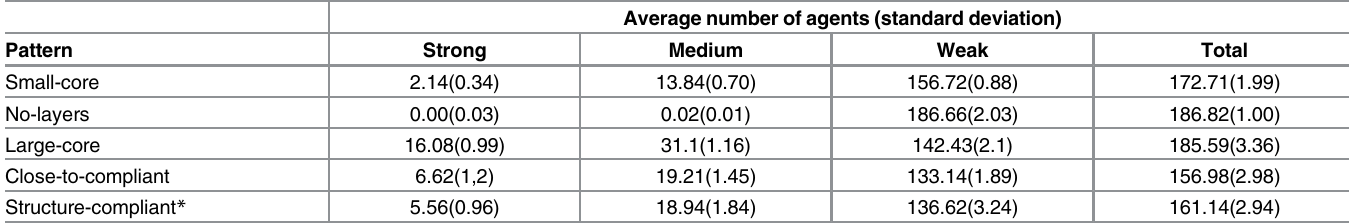
Table 5. Mean number of agents in each layer for the five different final social patterns identified by cluster analysis in the random initial condition.